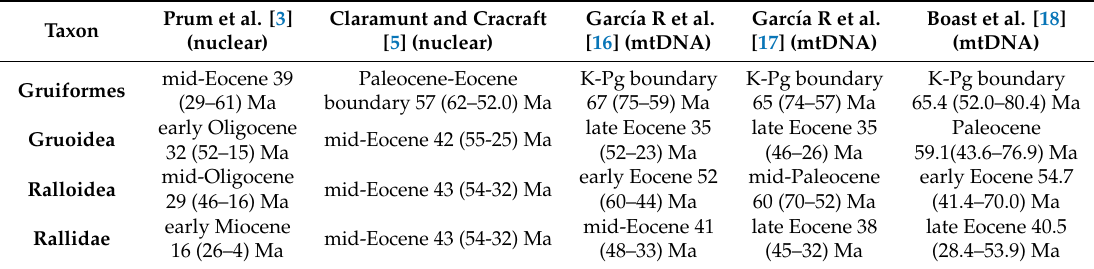
Table 1. Recently published divergence dates for Gruiformes and its major subclades. Mean ages are provided with 95% highest posterior density intervals in parentheses. Dates are estimated from published figures with the exception of those from Boast et al. [18] and the upper bound of Gruiformes in Claramunt and Cracraft [5]. Prum et al. [3] employed over 390,000 bases of genomic sequence data. Claramunt and Cracraft [5] used first and second codon positions of 1156 clock-like exons from Jarvis [2] (124,196 bases in total). Garc í a R et al. [16] used mitochondrial genomes. Garc í a R et al. [17] used partial sequences of several mitochondrial genes (cyt b , COI, 16S, ~2900 base pairs) and